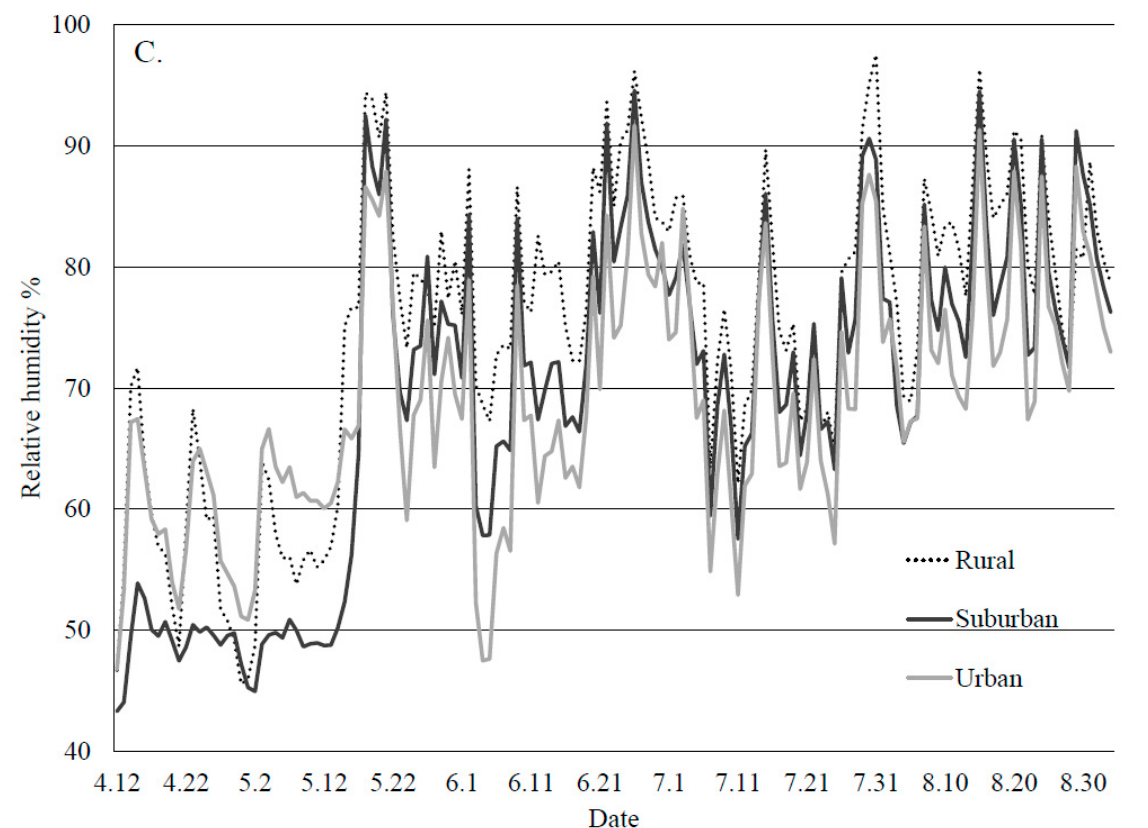
Figure 5. Temperature and humidity were measured every three hours at each site, directly next to one of the ovicups, in 2018. ( A ) Daily mean temperatures by land use type, ( B ) a histogram of the frequency that differences in daily mean temperatures between each land use type reached levels that may be sufficient to alter population growth rates, ( C ) daily mean relative humidity.